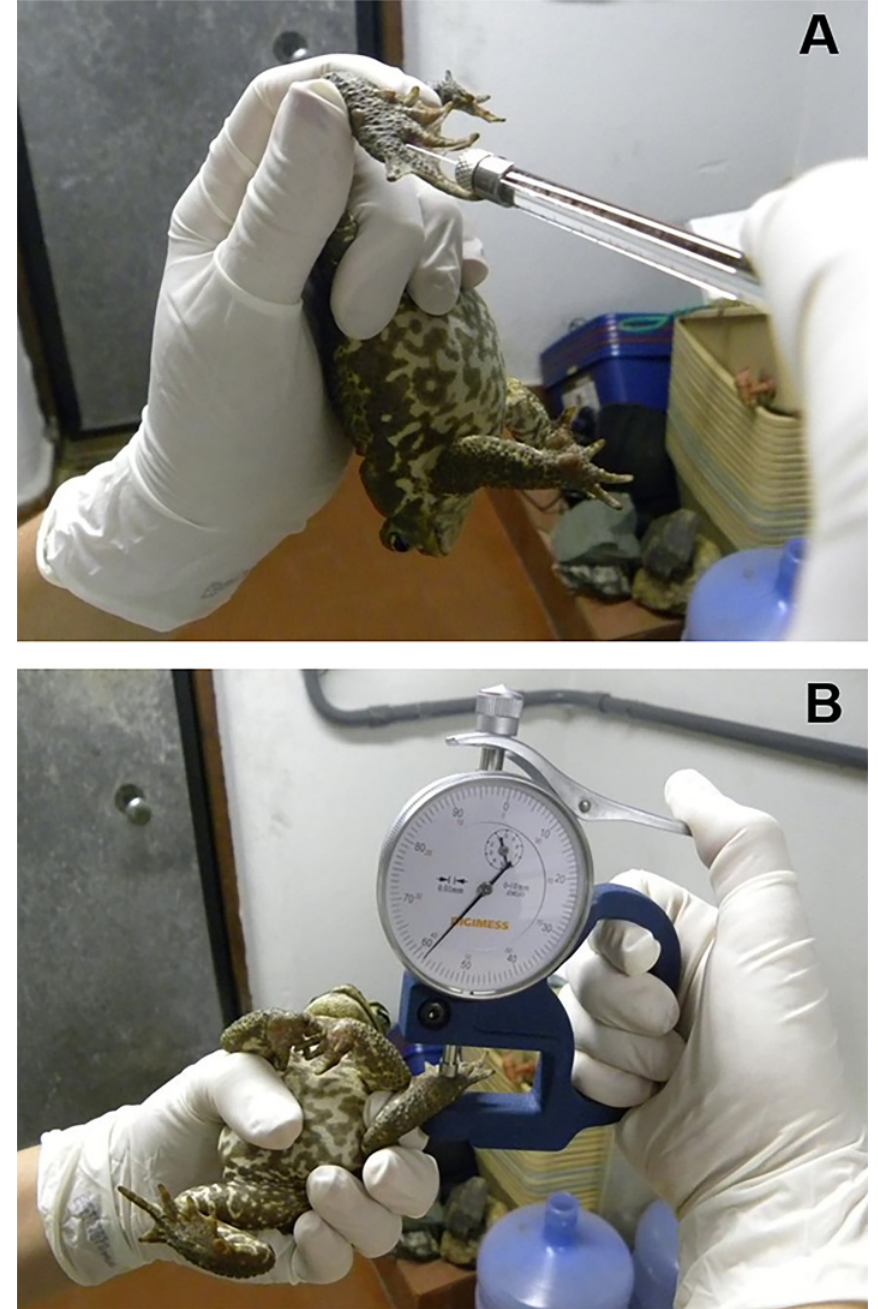
Fig 1. Phytohemagglutinin (PHA) skin-swelling assay. The hind fleshy base of the foot was injected with 10 μ l of PHA or sterile saline solution, using a glass syringe (A). The thickness of each hind fleshy base of the foot was measured prior and after 12h of the injection using a thickness gauge: Digimess — 0.01mm precision (B) (Photographs by Stefanny C. M. Titon).